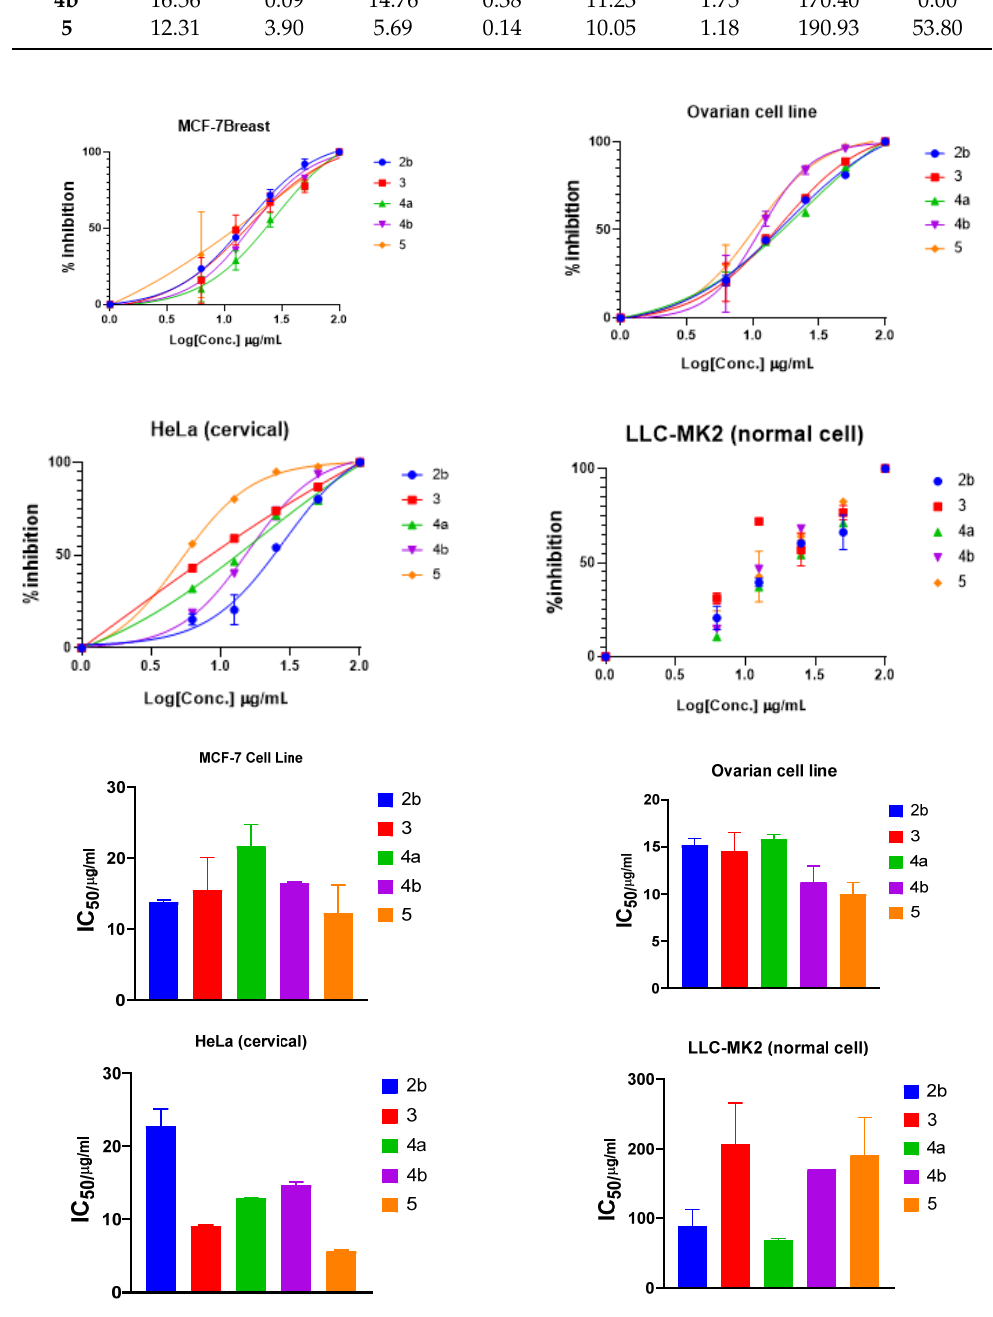
Figure 3. Inhibition and IC 50 of selected compounds in DMSO solutions toward MCF-7, Hela, Ovcar-3, and LLC-MK2 cell lines.